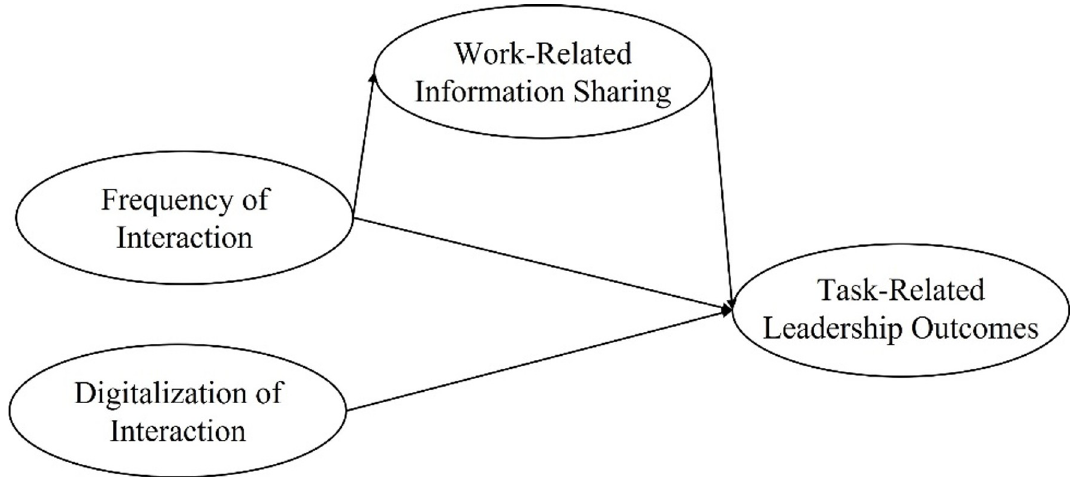
Fig 1. Theoretical model tested in the present research. Task-related leadership outcomes here are: norm clarity, goal clarity, and perceived task